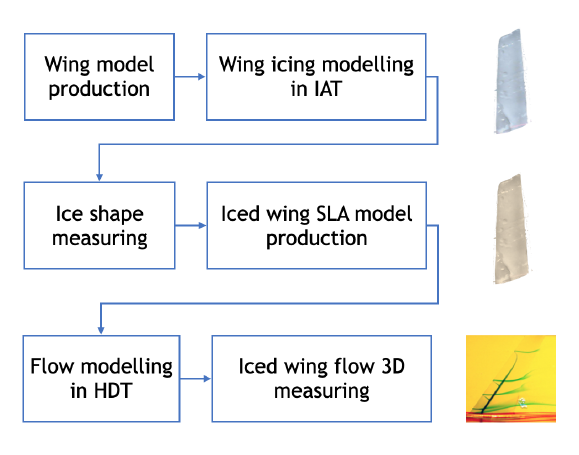
Figure 1. The project framework